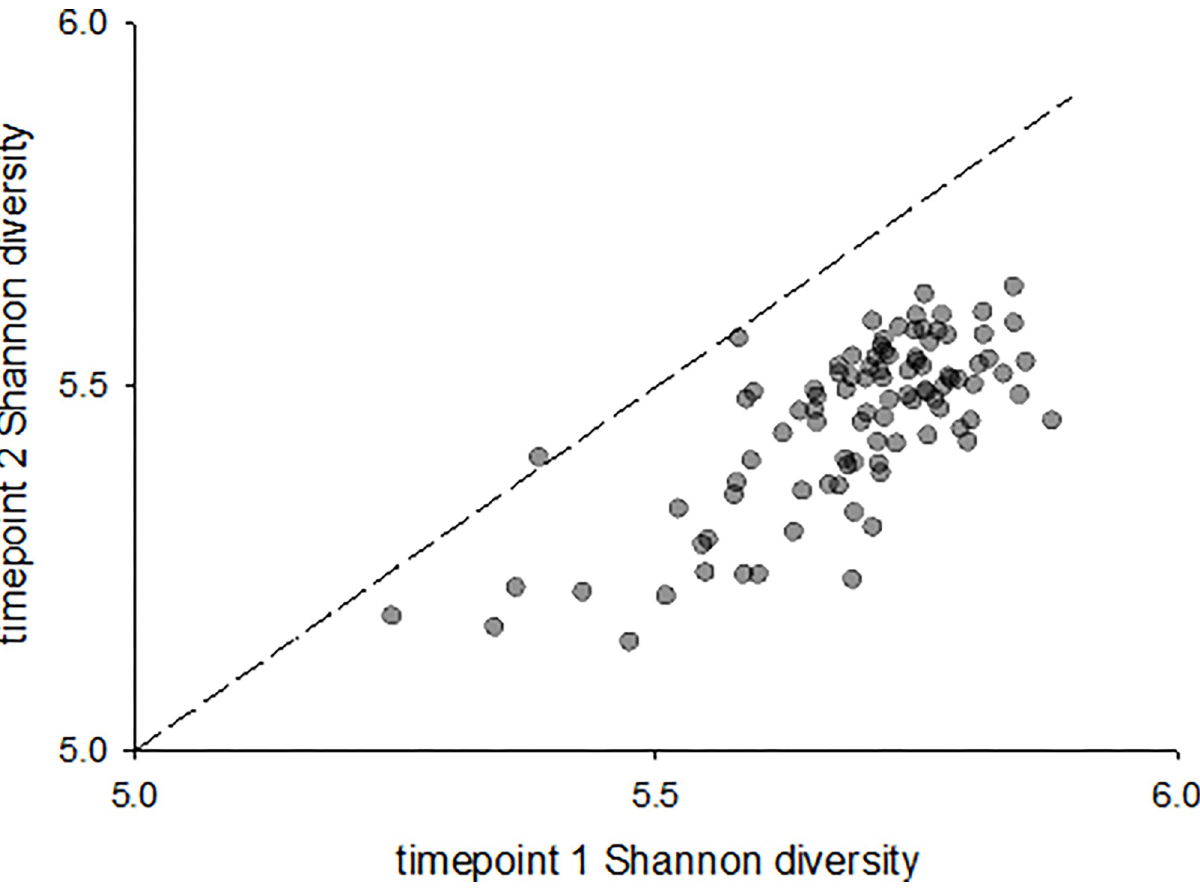
Fig 3. Shannon diversity is correlated across collections. Each datapoint represents one animal. Shannon diversity for the first and second timepoint from each animal is plotted on the x and y axis, respectively. y = x line is shown to visualize drop in α diversity between the two timepoints.